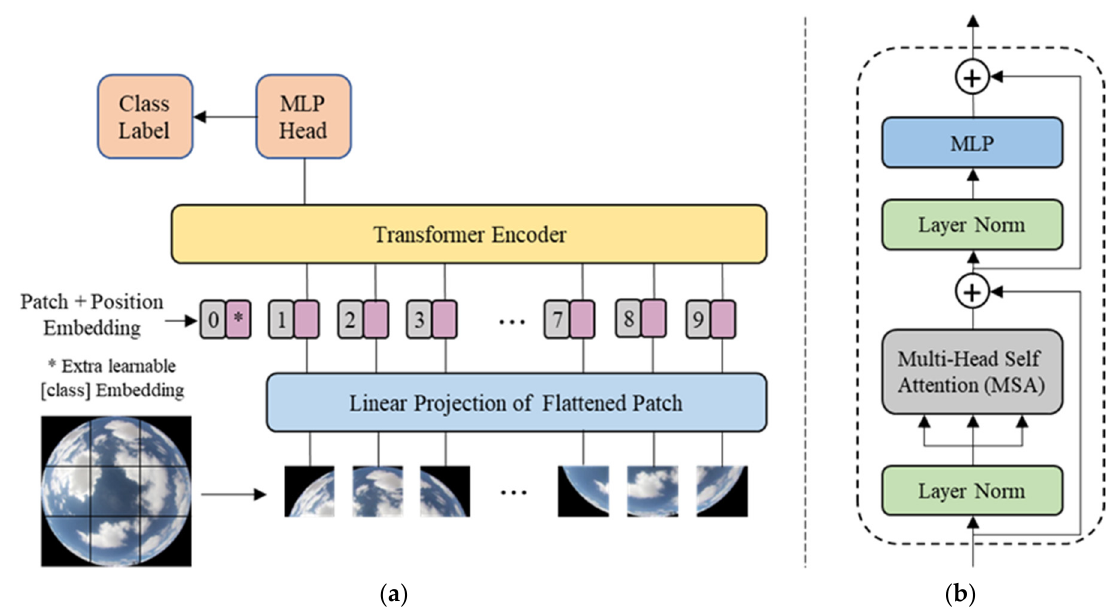
Figure 3. The structure of ( a ) the Vision Transformer (ViT) and ( b ) the transformer encoder. The structure of the transformer encoder is shown in Figure 3b. It is mainly composed of a multi-head self-attention (MSA) module and a feed-forward multilayer perceptron (MLP) [33]. MSA is the core module of the encoder, which will be explained in detail below. MLP contains two fully connected layers with a Gaussian Error Linear Unit (GeLU) activation function between the layers [51]. In addition, the two parts of the encoder both use residual connections, while a normalization layer is added before the input of each part. Finally, GCI classification is performed using the MLP head based on the features trained by the transformer encoder.